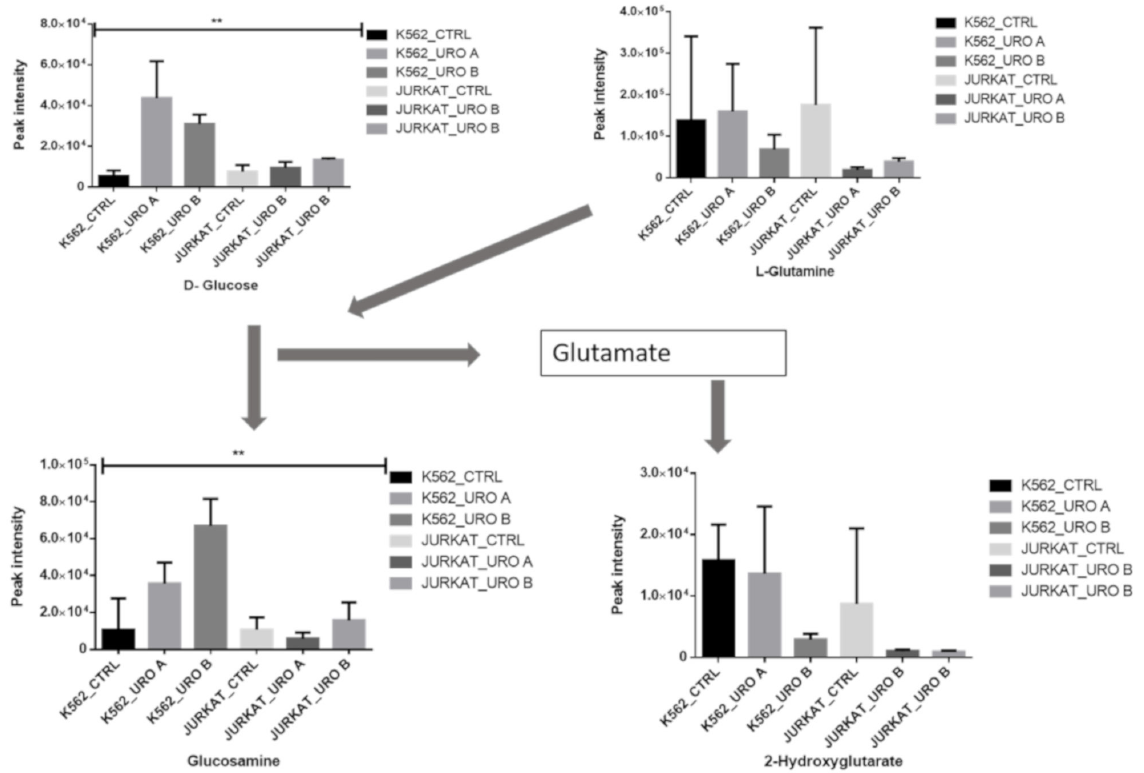
Figure 4. Urolithin A and B both alter glutamine pathways in leukemic cells. Quantitative levels of various metabolites involved in glutamine pathway of control and urolithin A- and urolithin-B treated cells, ** p <